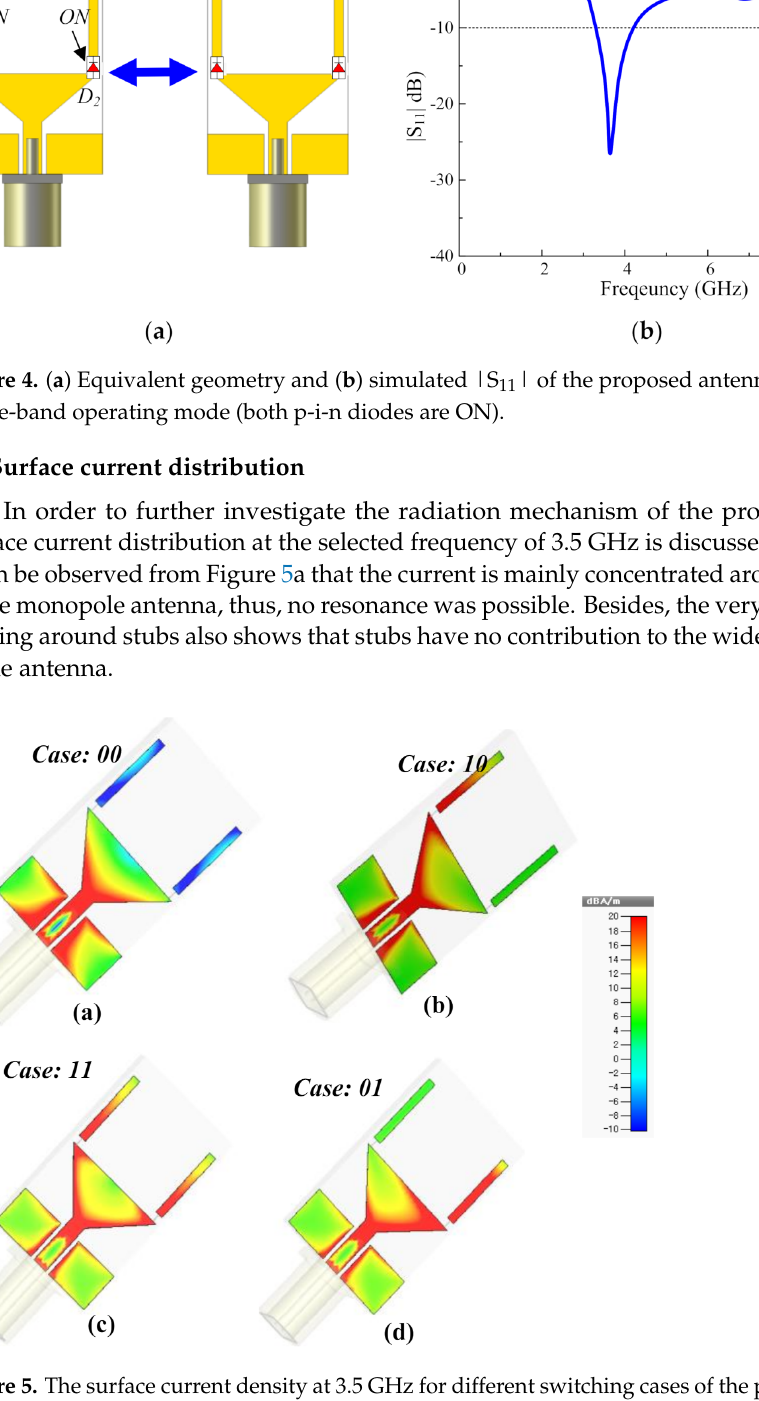
Figure 5. The surface current density at 3.5 GHz for different switching cases of the proposed antenna. ( a ) Case-00; ( b ) Case-10; ( c ) Case-11; ( d )